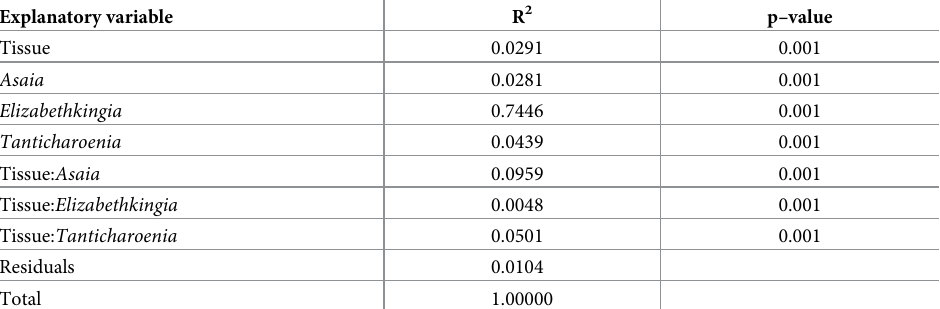
Table 1. A PERMANOVA to test for the association between beta diversity (quantified by Bray-Curtis dissimilari- ties) and explanatory variables representing tissue type and the raw abundance of the three dominant taxa in the data set.